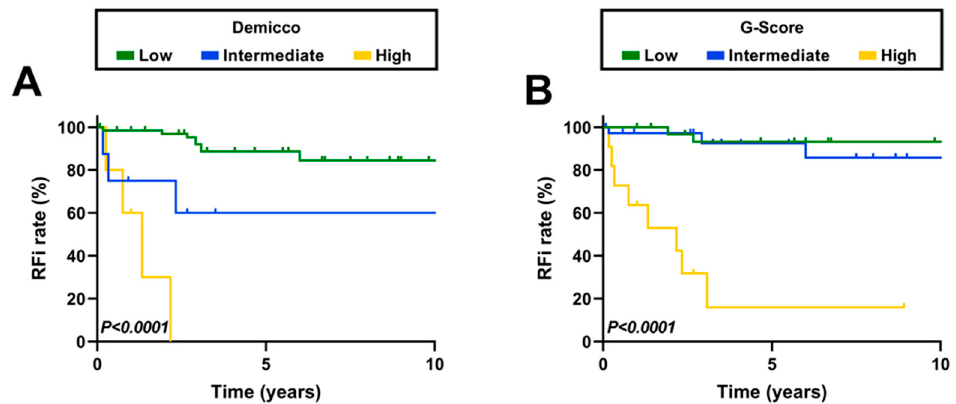
Scheme 3. Prediction of recurrence risk using Demicco and G-Score. Kaplan–Meier survival curve analysis of recurrence-free interval including cases classified by using Demicco ( A ) and G-Score ( B ) RSS. Abbreviations: RSS: Risk stratification system.